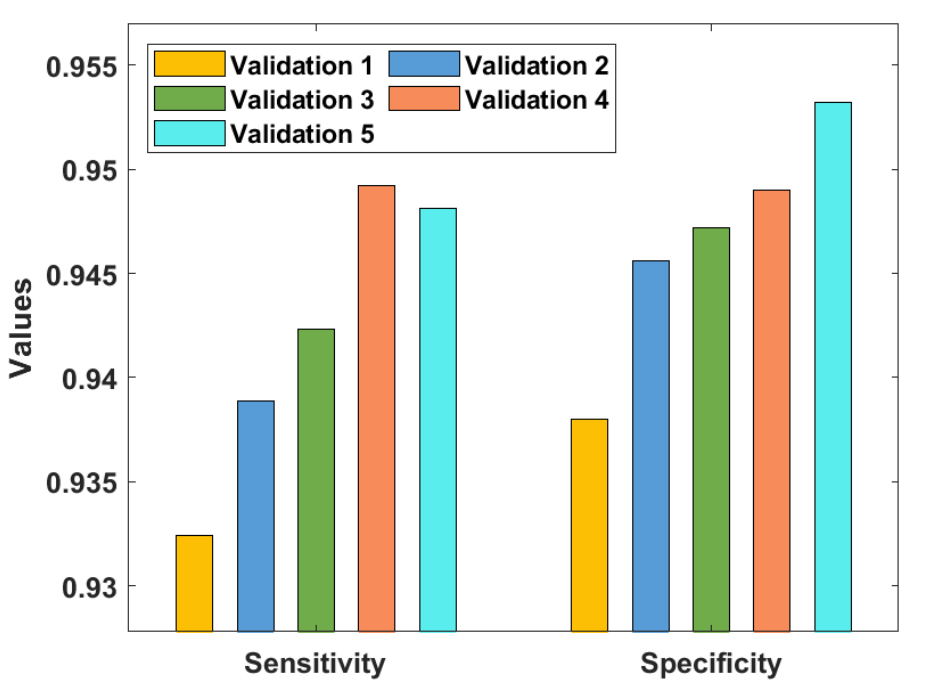
Figure 5. Result analysis of the GSO-IDCNN approach with respect to 𝑠𝑒𝑛𝑠 𝑦 and 𝑠𝑝𝑒𝑐 𝑦 .